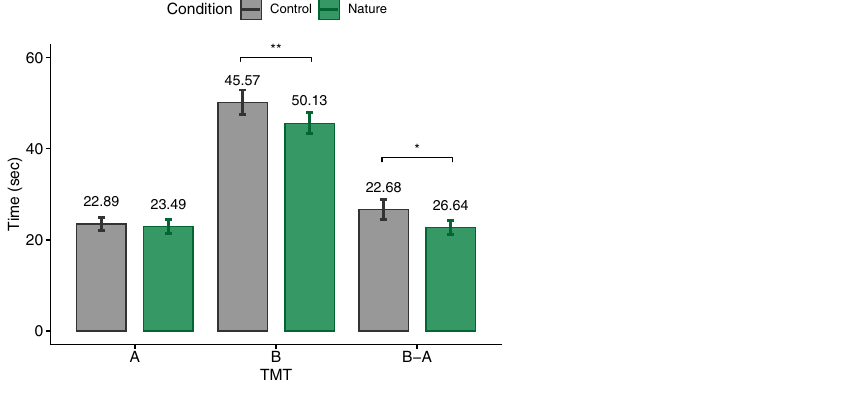
Figure 3. Trail making tests